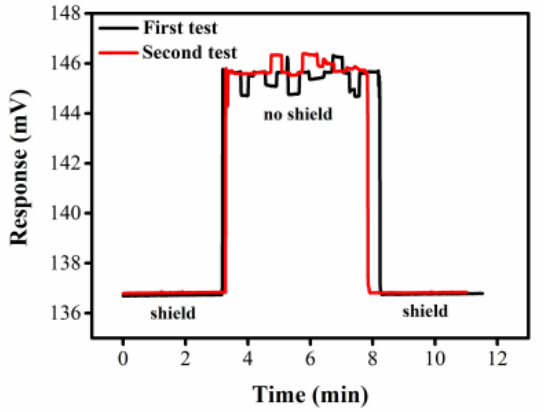
Figure 5. Output signals of the ultrapure water by DISODCD sensor with or without shield configuration.